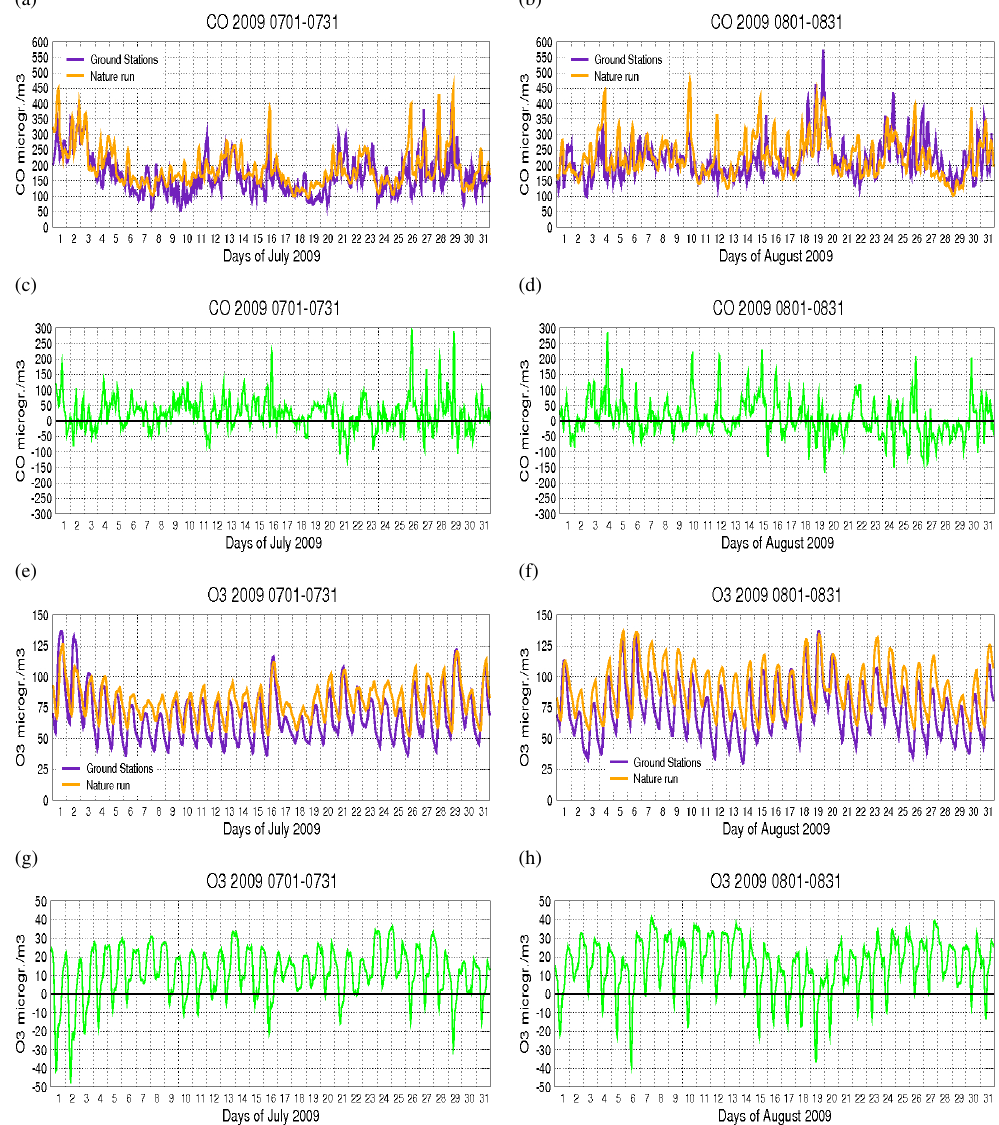
Fig. 3. Timeseries of the CO concentrations from the nature run (orange) and measured by ground based stations (purple), averaged each hour over France in July 2009 (a) and August 2009 (b) and respective differences between the nature run and the surface observations – (c) and (d) . (e) – (h) are as (a) – (d) but for O 3 . For CO, all types of ground based stations are considered because of their limited